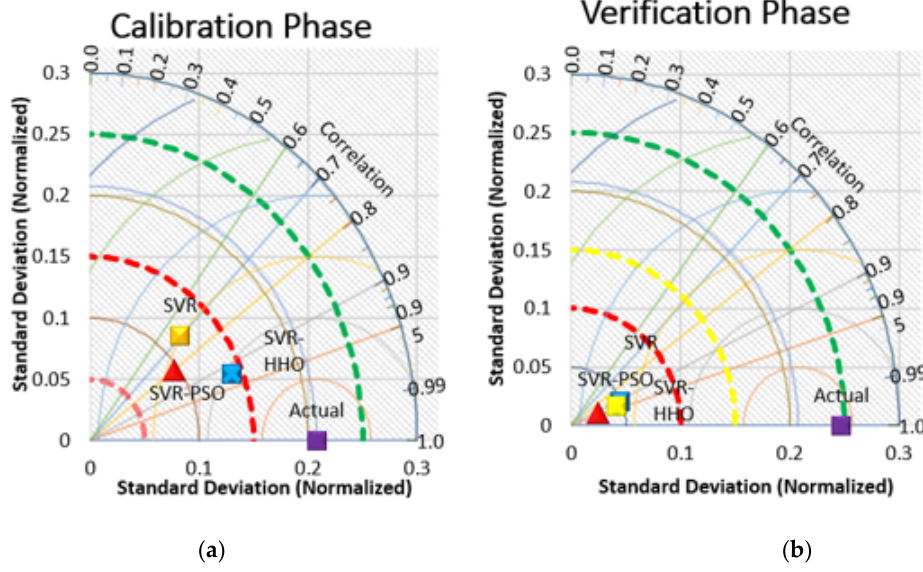
Figure 21. Taylor diagram for the models in the ( a ) calibration and ( b ) verification stages.